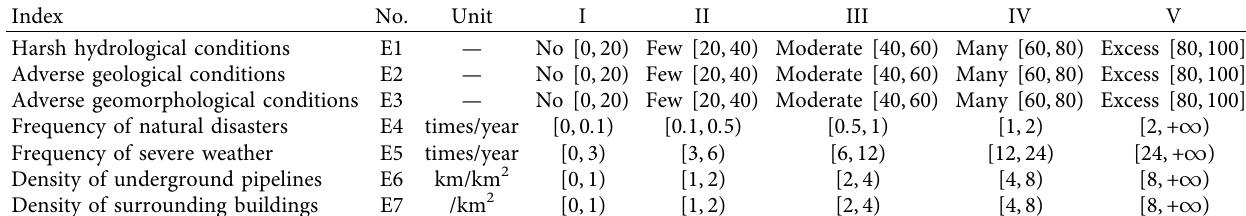
Figure 3: Distribution of expert work units. Table 2: Classification standard for environmental risk